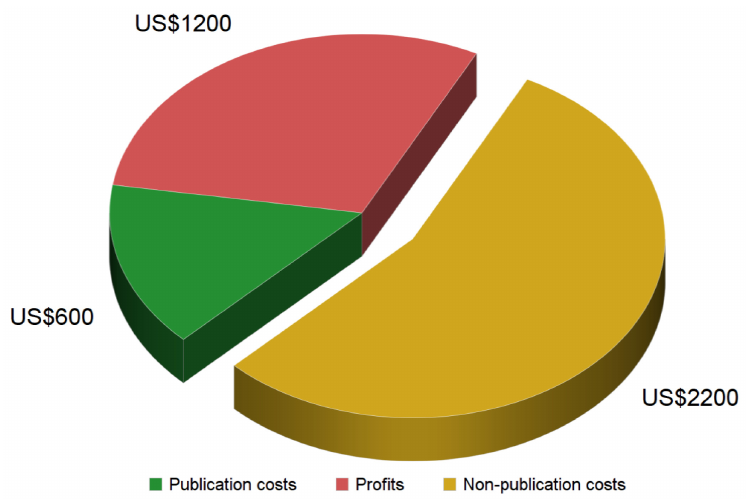
Figure 1. Subscription price and cost items. Assuming the commonly accepted US$4,000 price tag for a subscription article, published profit margins of 30% and our calculation of about US$600 in publication costs for a full-service subscription article (scenario A/B, see Table 4), there remain US$2,200 in non-publication costs per